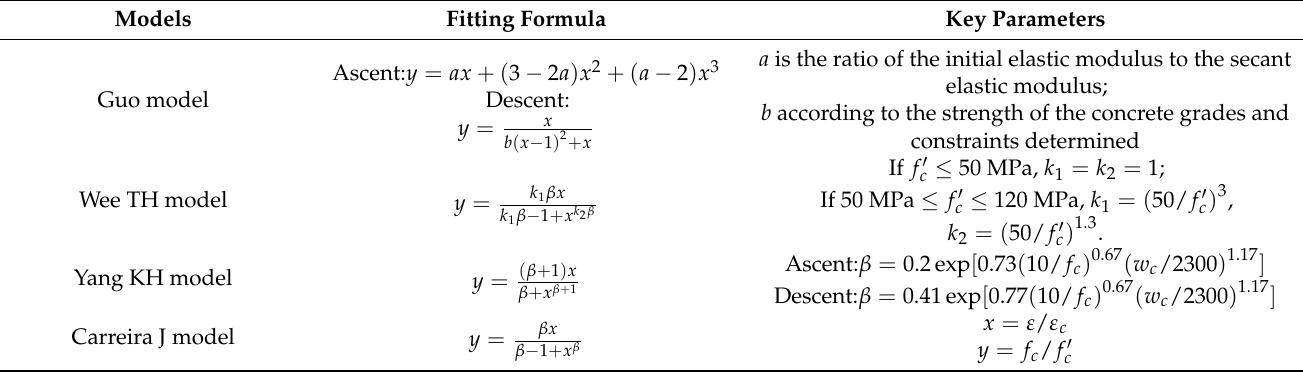
Figure 11. The conversion rate of dissipative energy. Figure 11. the conversion rate of dissipative energy. Figure 11. the conversion rate of dissipative energy. Table 3. Existing stress–strain constitutive models of concrete under uniaxial